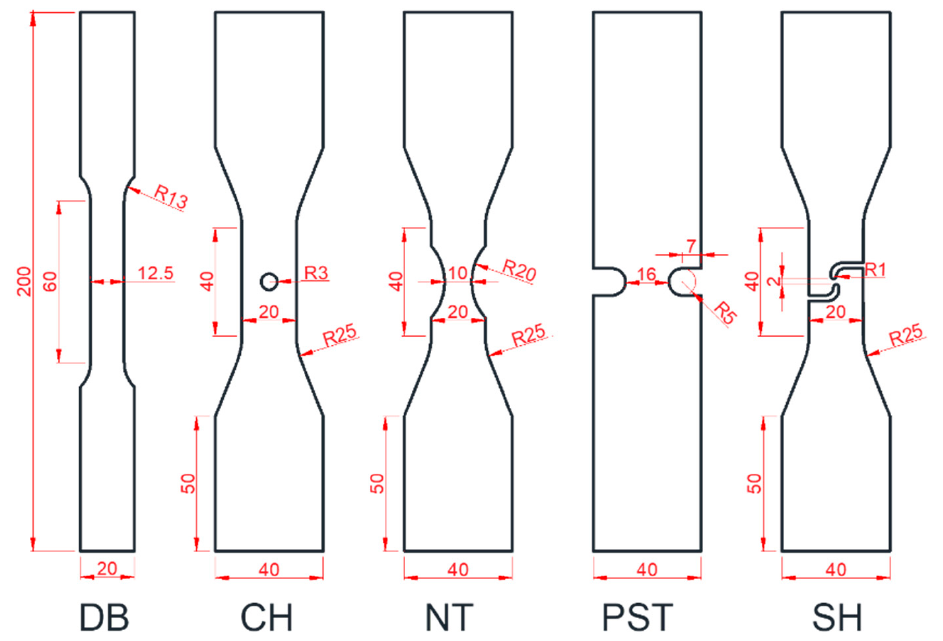
Figure 3. Specimen geometries and dimensions (unit: mm).